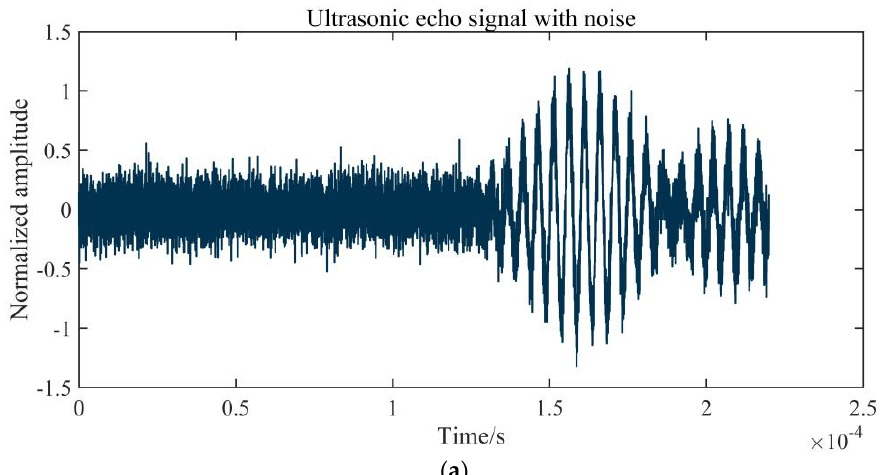
Figure 1. A typical ultrasonic echo signal.